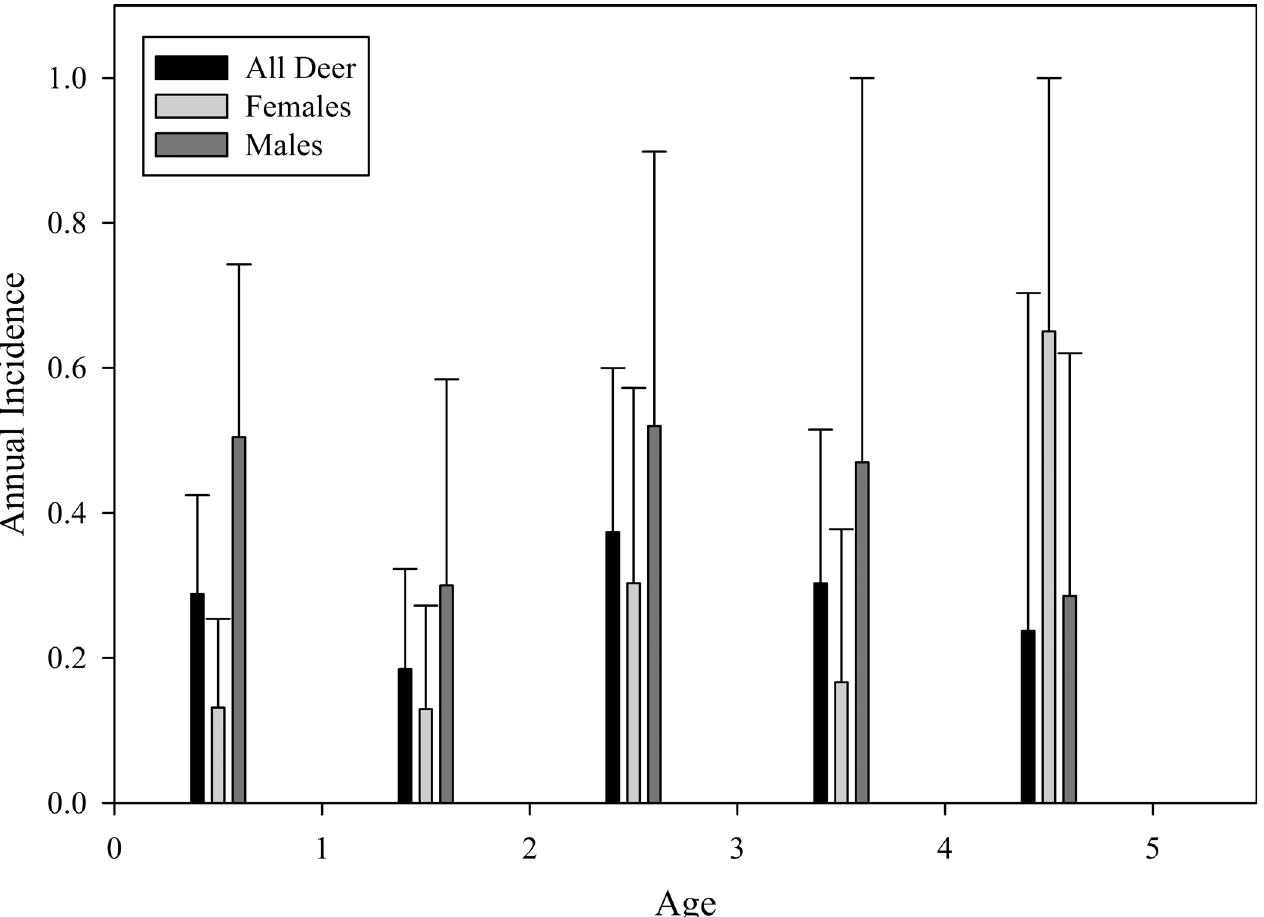
Fig 3. Annual Incidence Rates. Chronic wasting disease (CWD) annual incidence rate by sex and age class of white-tailed deer captured, CWD- tested annually, radio-collared, and monitored by radio-telemetry SW of Glenrock, WY (2003 – 2010). The CWD incidence was calculated by Kaplan-Meier time to event